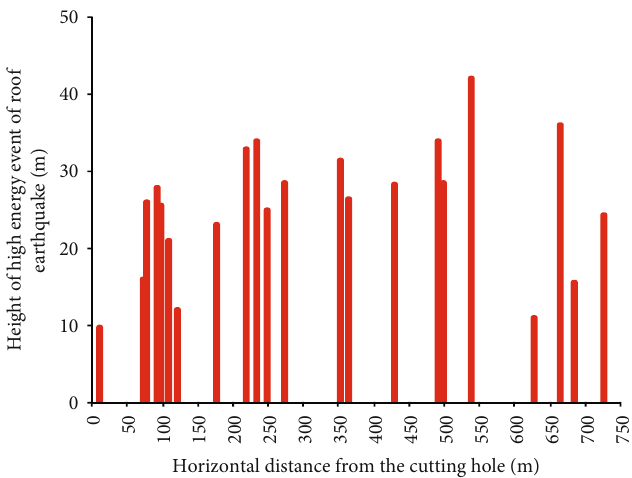
Figure 10: Distribution diagram of high-energy events of roof with the mining of working